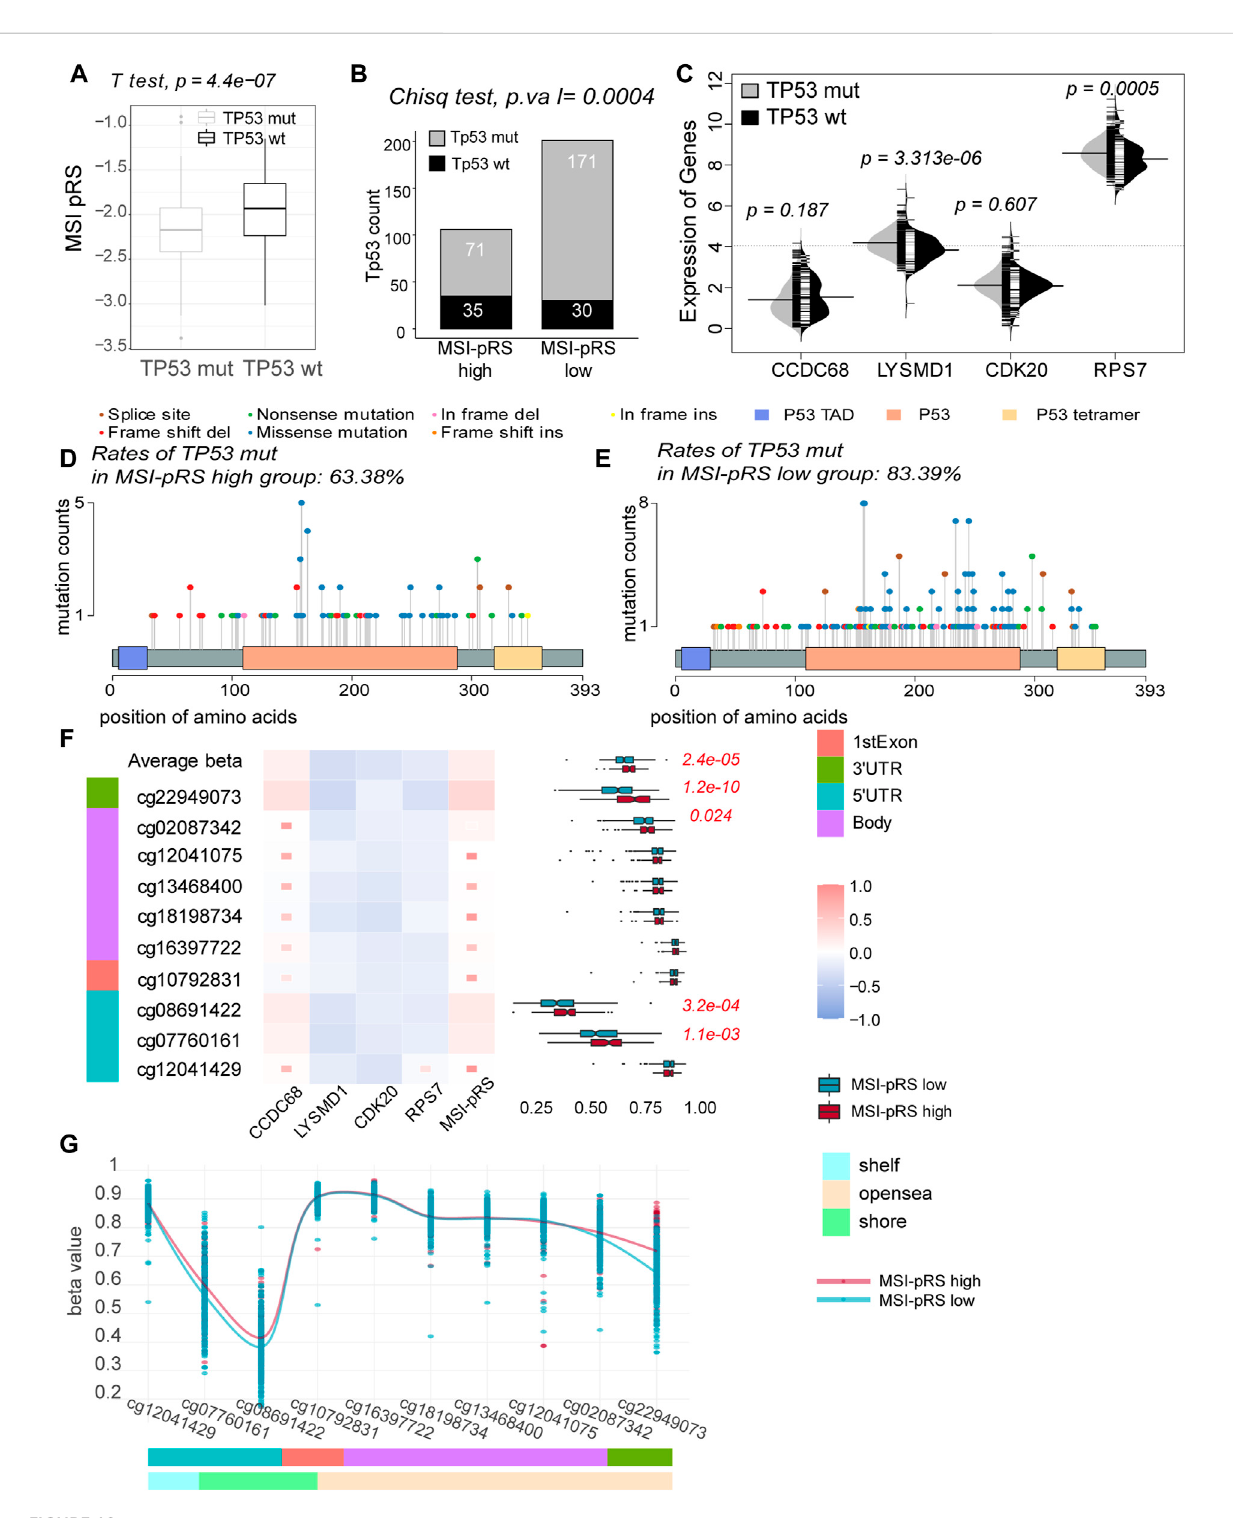
FIGURE 10 Relationship between the MSI-related prognostic risk score (MSI-pRS) and TP53 status. (A) TP53 mut had lower MSI-pRS than the TP53 wt. (B) Incidence of TP53 mutations was more frequent in the low MSI-pRS group in the TCGA training cohort. (C) Comparison of the four elements used to construct the MSI-pRS model between TP53 mut and TP53 wt groups. LYSMD1 and RPS7 were higher in the TP53 mut group. (D) Landscape of TP53 mutations in the MSI-pRS high group. (E) Landscape of TP53 mutations in the MSI-pRS low group. (F) Correlation of the MSI-PRS and its elements with DNA methylation probes on TP53 genes. MSI-pRS and CCDC68 were positively correlated with TP53 DNA methylation, whereas LYSMD1, CDK20, and RPS7 were negatively correlated with TP53 DNA methylation. (G) Comparison of DNA methylation on TP53 genes between MSI-pRS high and low groups in TCGA LUSC